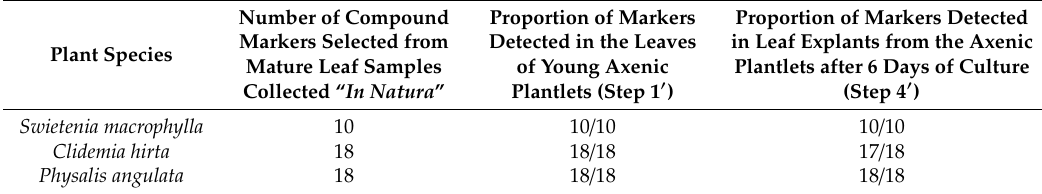
Table 3. Survey of the detection of the selected compound markers when the starting material is leaves from axenic plantlets.